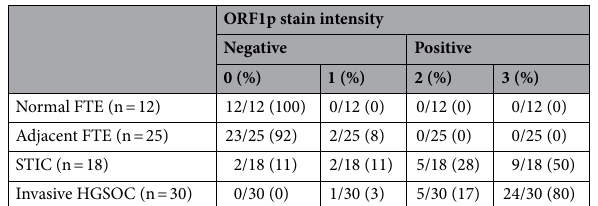
ORF1p stain intensity